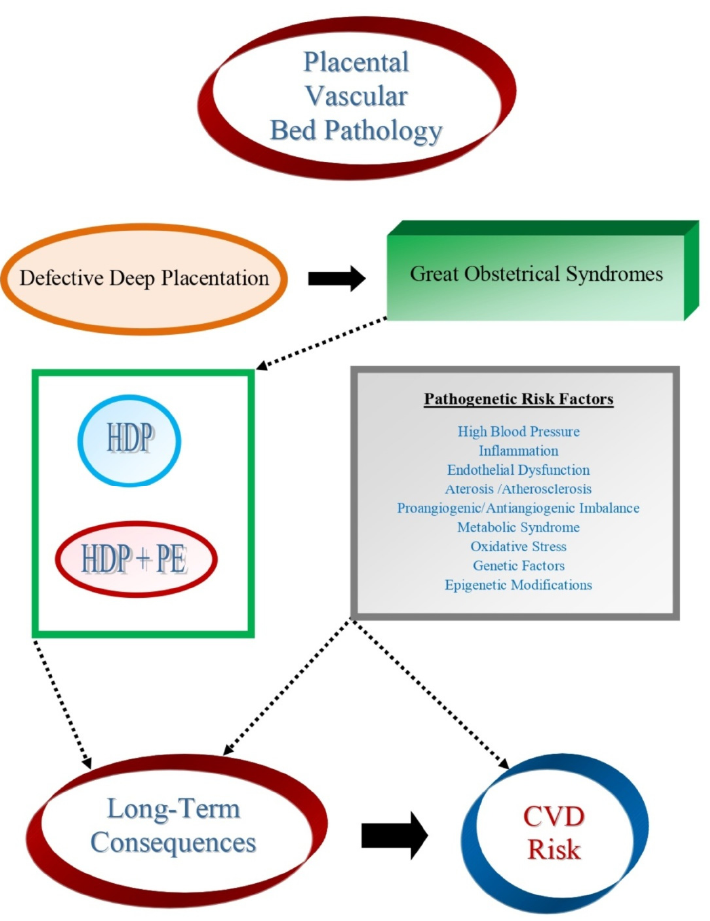
Figure 4. Placental vascular bed pathology is at the core of defective deep placentation which leads virtually to all Great Obstetrical Syndromes. In particular, hypertensive disease in pregnancy (HDP) and its association with preeclampsia (PE) share a series of risk factors with cardiovascular diseases (CVD) that may be responsible for long term consequences of placental vascular bed pathology and the increased incidence of CVD risk among mothers and their off-springs.